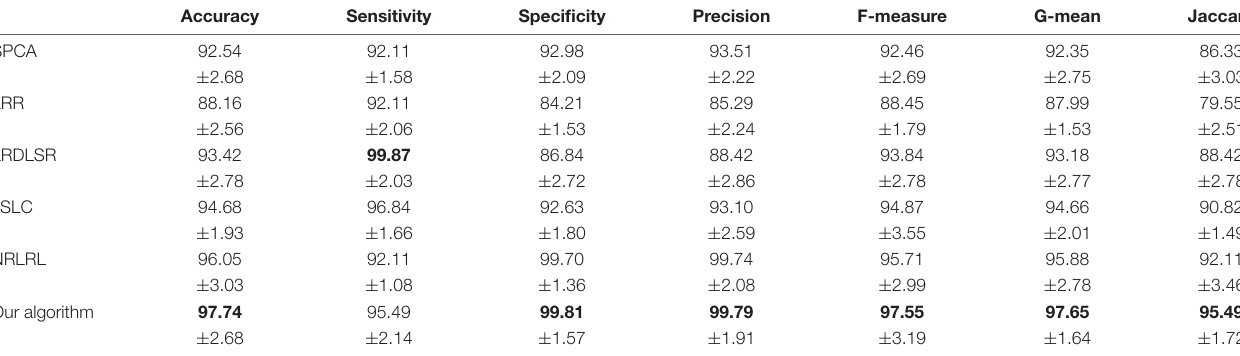
TABLE 1 | Classification results of the comparison algorithms in HC and AD dataset.